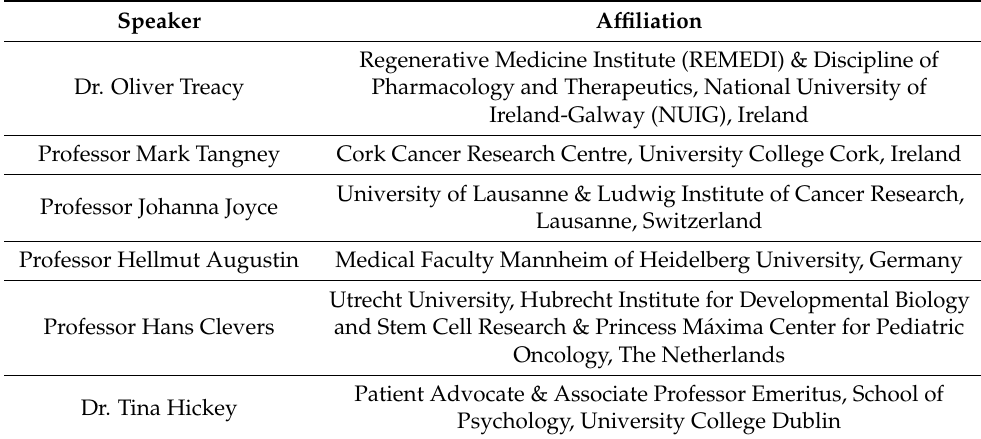
Table A1. Contributing speakers who presented their work at the Irish Association for Cancer Research virtual annual meeting